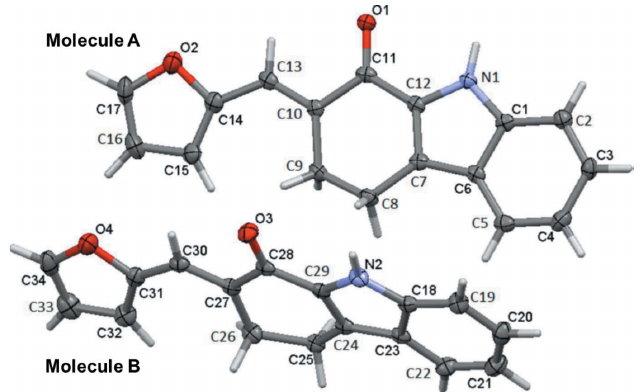
Figure 1 The molecular structure of the two independent molecules ( A and B ) of the title compound, with the atom labelling. Displacement ellipsoids are drawn at the 50% probability